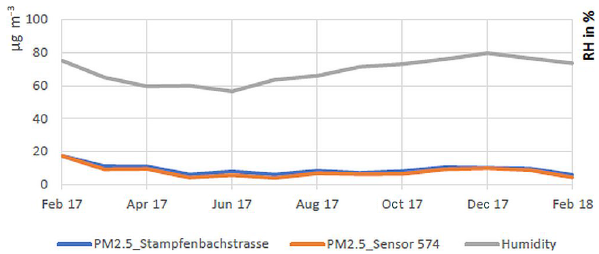
Figure 11. Monthly average PM and relative-humidity values for Stampfenbachstrasse.